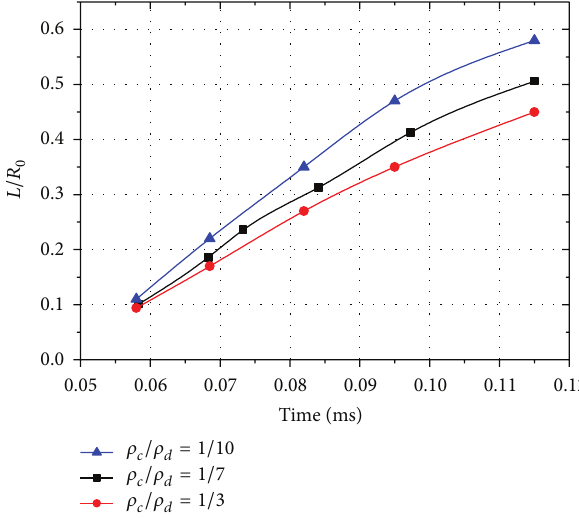
Figure10:Aspectratiooffilamentlengthtodropletradiuswithtime for different droplet